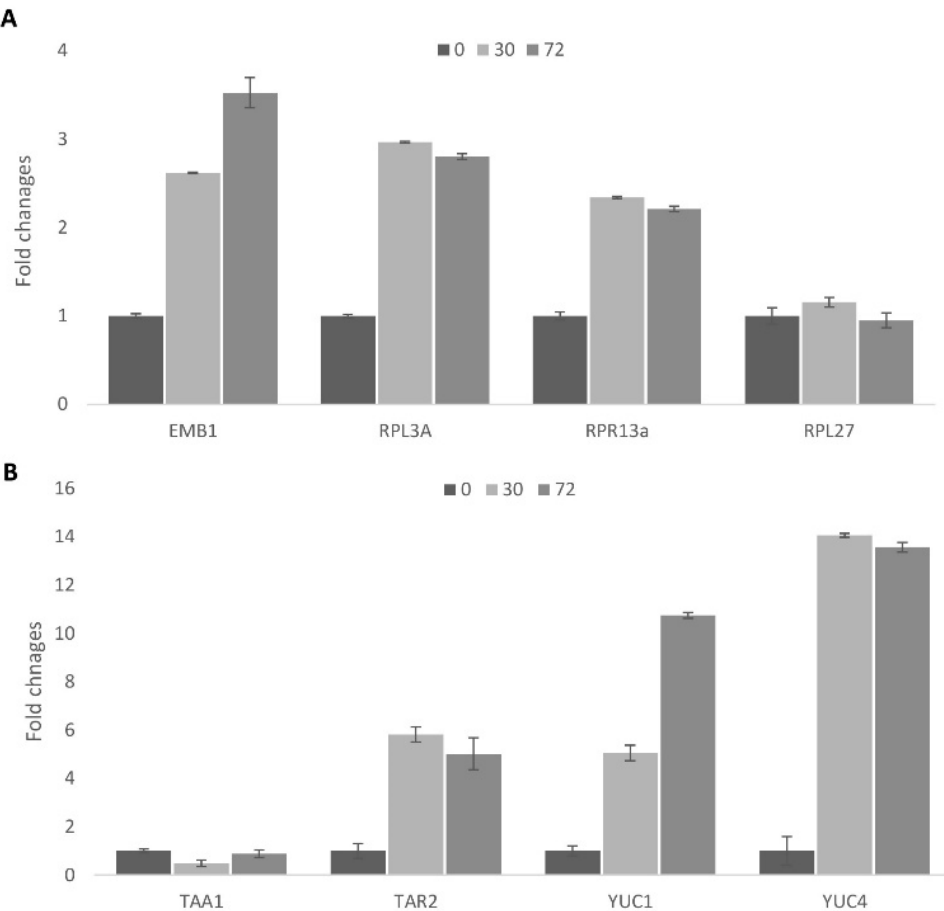
Figure 3. Analysis of gene expressions by qPCR in Arabidopsis protoplasts. The Actin (ACT2) gene, which does not change its expression in protoplasts, was used as a reference. X-axis: genes; Y-axis: fold changes; 0, 30 and 72 hours of incubation. Error bar means standard error. ( A ) nucleus related genes; ( B ) auxin biosynthesis